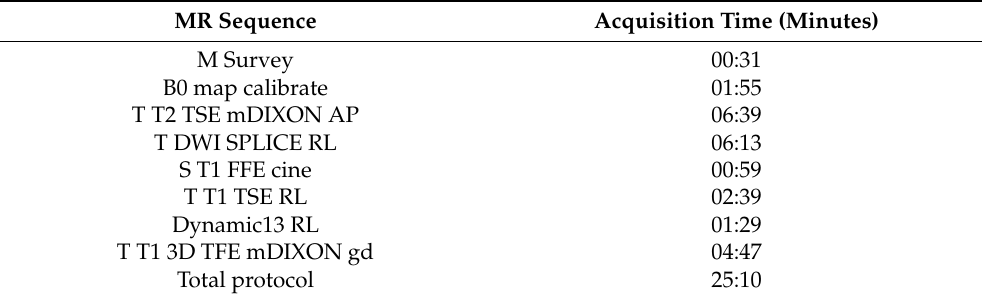
Table 1. Overview of acquisition times per sequence for a head and neck (pharynx) MRI protocol. MR